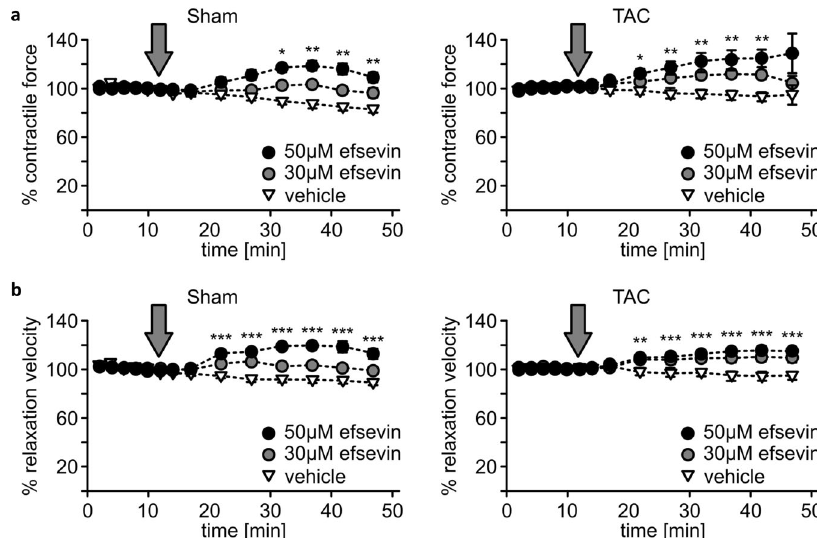
Fig. 9 Enhanced contractile force and accelerated relaxation speed in myocardial tissue upon VDAC2 activation. a Measurement of relative contractile force in organotypic myocardial slices from both Sham- (left panel) and TAC-operated mice (right panel) after superfusion with either 30 or 50 µ M of the VDAC2 agonist efsevin. Each dot represents the quanti fi cation of twitch amplitudes over 20 s at indicated time points. The gray arrow indicates the start of efsevin superfusion (left panel: DMSO vs. 30 μ M Efsevin: 10 min p = 0.016, 32 min p = 0.010, 37 min p = 0.0004, 42 min p = 0.0012 and 47 min p = 0.0062; DMSO vs. 50 μ M Efsevin: 22 min p = 0.0007, 27 – 47 min p < 0.0001, respectively) (right panel: DMSO vs. 30 μ M Efsevin: 17 min p = 0.0038, 22 min p = 0.0009, 27 min p = 0.00031, 32 min p = 0.00029, 37 min p = 0.00015, 42 min p = 0.00073; DMSO vs. 50 μ M Efsevin: 22 min p = 0.0218, 27 min p = 0.0044, 32 min p = 0.0037, 37 min p = 0.0031, 42 min p = 0.0034). b Relaxation speed of twitches of myocardial slices shown in a ( N = 8, n = 22 slices for TAC, N = 6, n = 14 slices for Sham) (left panel: DMSO vs. 30 μ M Efsevin: 22 min p = 0.0072, 27 min p = 0.00019, 32 min p = 0.044, 37